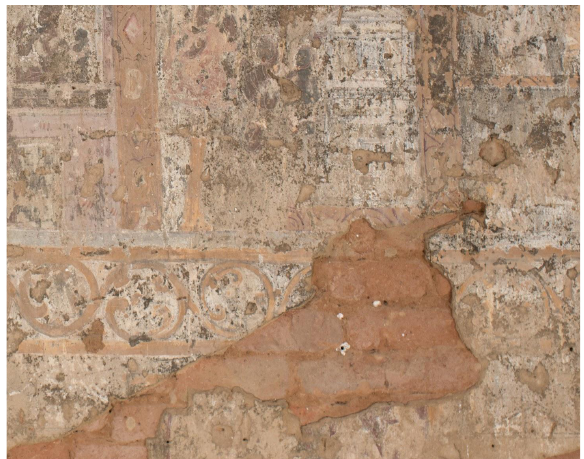
Figure 1. The stratigraphy of wall paintings in Myin- pya-gu—a temple in Old Bagan,